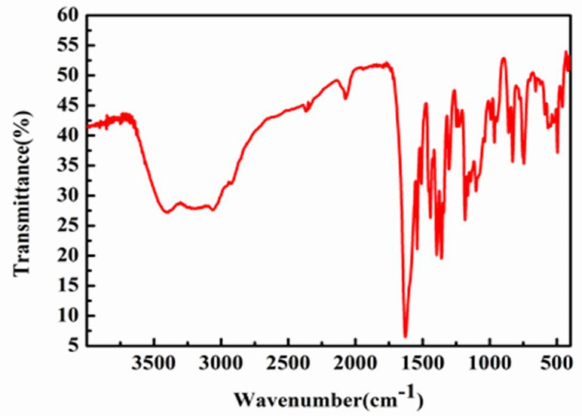
Figure 7. The IR spectrum of Complex 1.